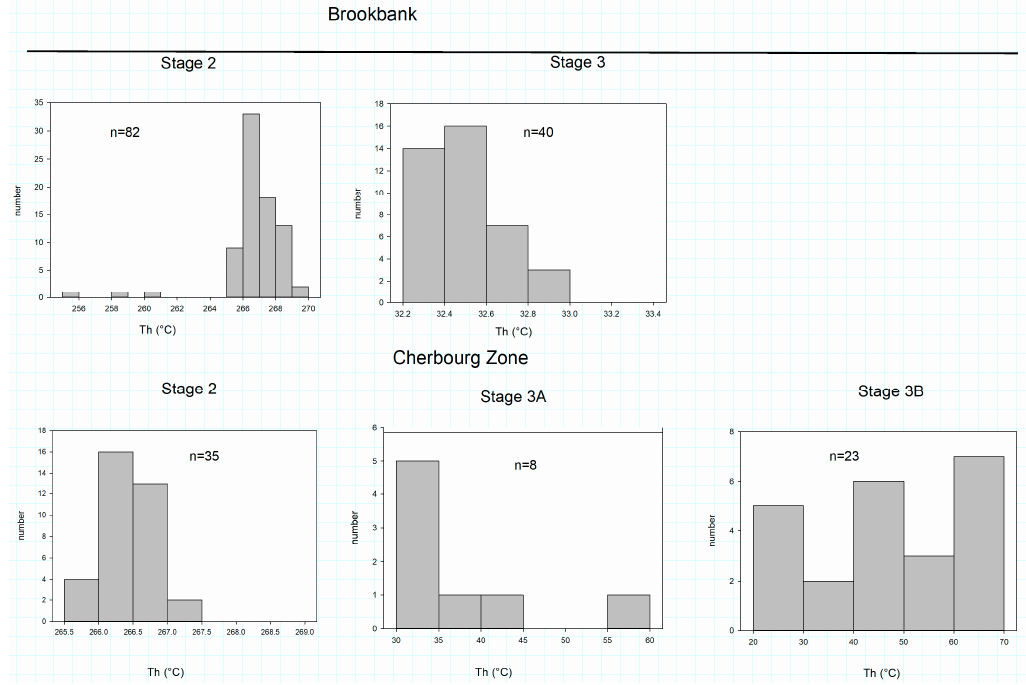
Figure 4. Comparative homogenization temperatures of the stages at Brookbank and the Cherbourg Zone.